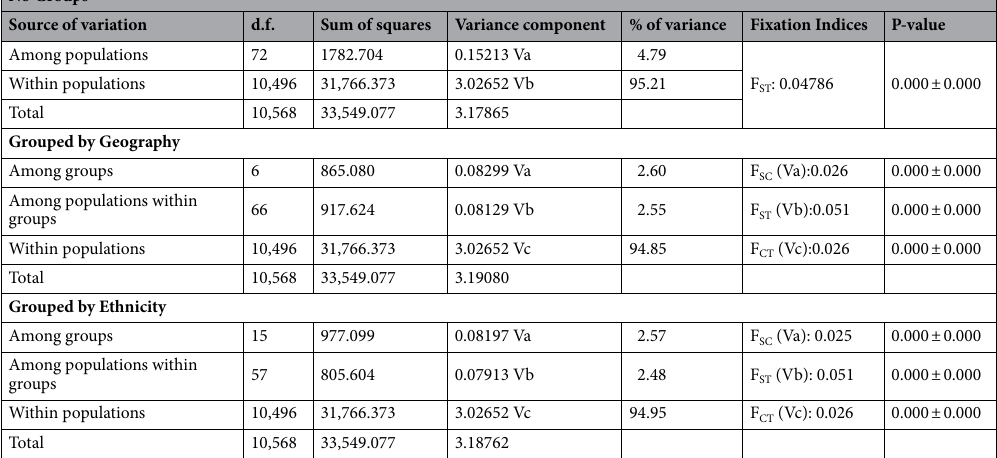
Table 2. AMOVA results for mtDNA HVS-1 sequences in KPP and comparative populations.